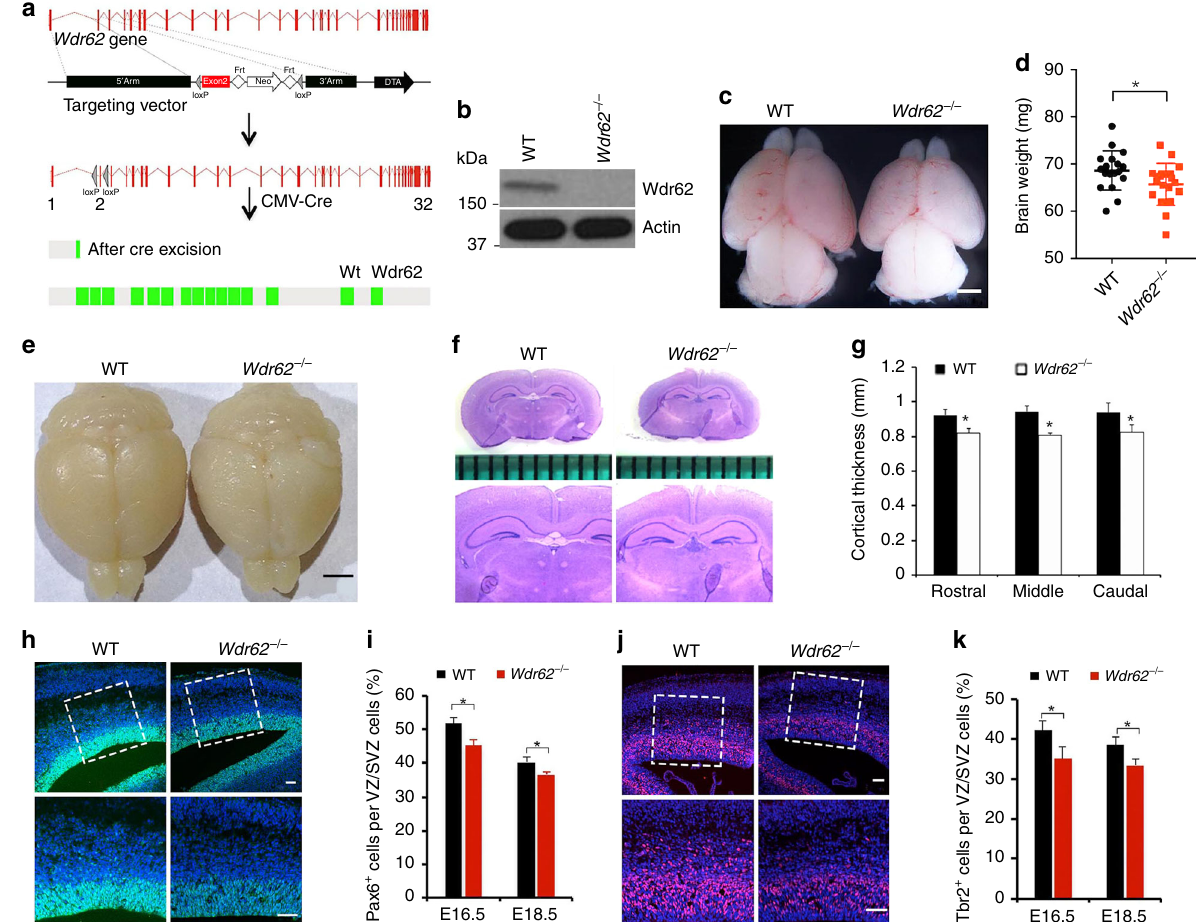
Fig. 3 Wdr62 deletion in mice results in smaller brain size and reduced NPCs. a Schematic diagram of strategy for Wdr62 null mouse generation. b Western blot analyses of Wdr62 protein expression in mouse embryonic fi broblasts (MEFs) isolated from E14.5 embryos. β -actin serves as the control. c , e Dorsal views of E18.5 and P30 mouse brains. Scale bars: 1 and 2 mm. d Statistical analysis of E18.5 WT ( n = 17) or mutant ( n = 17) brain weights. * P < 0.05 (Student ’ s t -test). f Coronal sections of P30 cerebral cortex stained with haematoxylin and eosin. The lower panels are the enlargements of upper panels . g Quanti fi cation of radial thickness in neocortex. Error bars indicate SEM of 9 sections at comparable positions along the rostral/caudal axis of cerebral cortex from three independent experiments. * P < 0.05 (Student ’ s t -test). h , j Confocal microscope images of coronal sections of E16.5 cerebral cortex stained with antibodies against Pax6 (green, h ) or Tbr2 (red, j ). Hoechst stains nuclei (blue). Lower panels are the enlargements from the white boxed areas in the upper panels. Scale bars: 50 μ m. i , k Quanti fi cation of the percentage of Pax6-positive and Tbr2-positive cells per total number of NPCs within VZ/SVZ. Error bars represent SEM of 9 sections from three independent experiments. * P < 0.05 (Student ’ s t